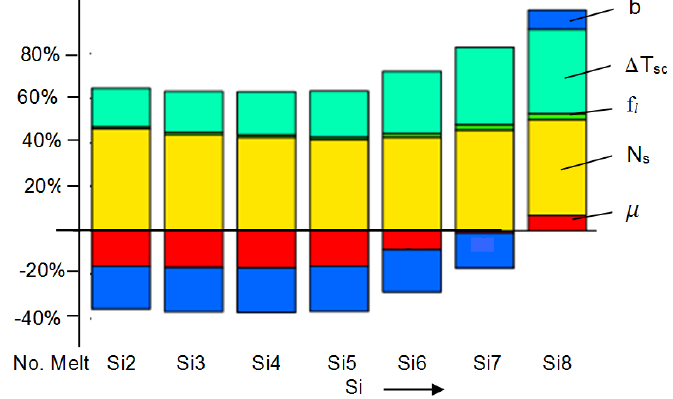
Figure 15. Silicon intensity effect on the CT index, through f , μ  T sc , N s and b (− CT decreases; + CT